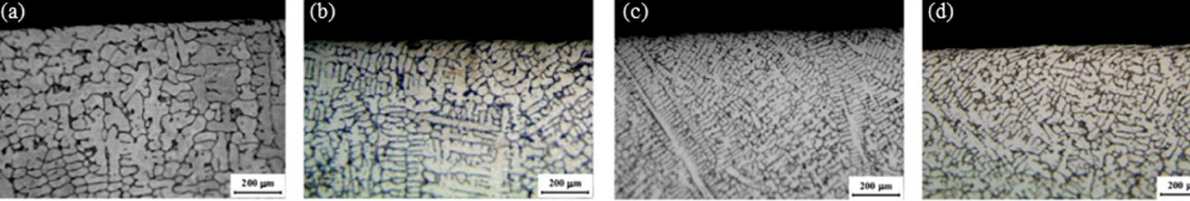
Figure 28. Microstructure of Fe-based alloy laser cladding coating (the laser power is 1.9 kw, and the scanning speed is 200 mm/min): ( a ) without La 2 O 3 ; ( b ) with 0.4% La 2 O 3 ; ( c ) with 1.2% La 2 O 3 ; ( d ) with 2.0% La 2 O 3 [58].